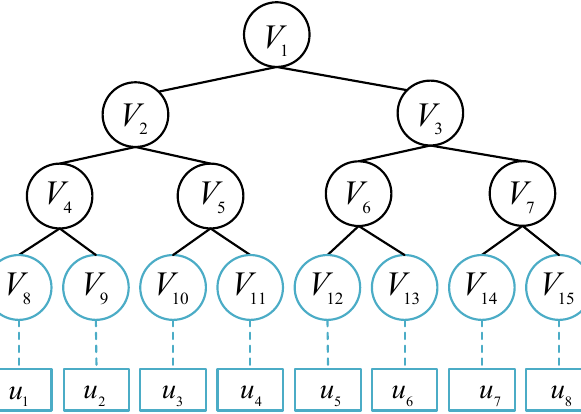
Figure 3. The key encryption key tree.